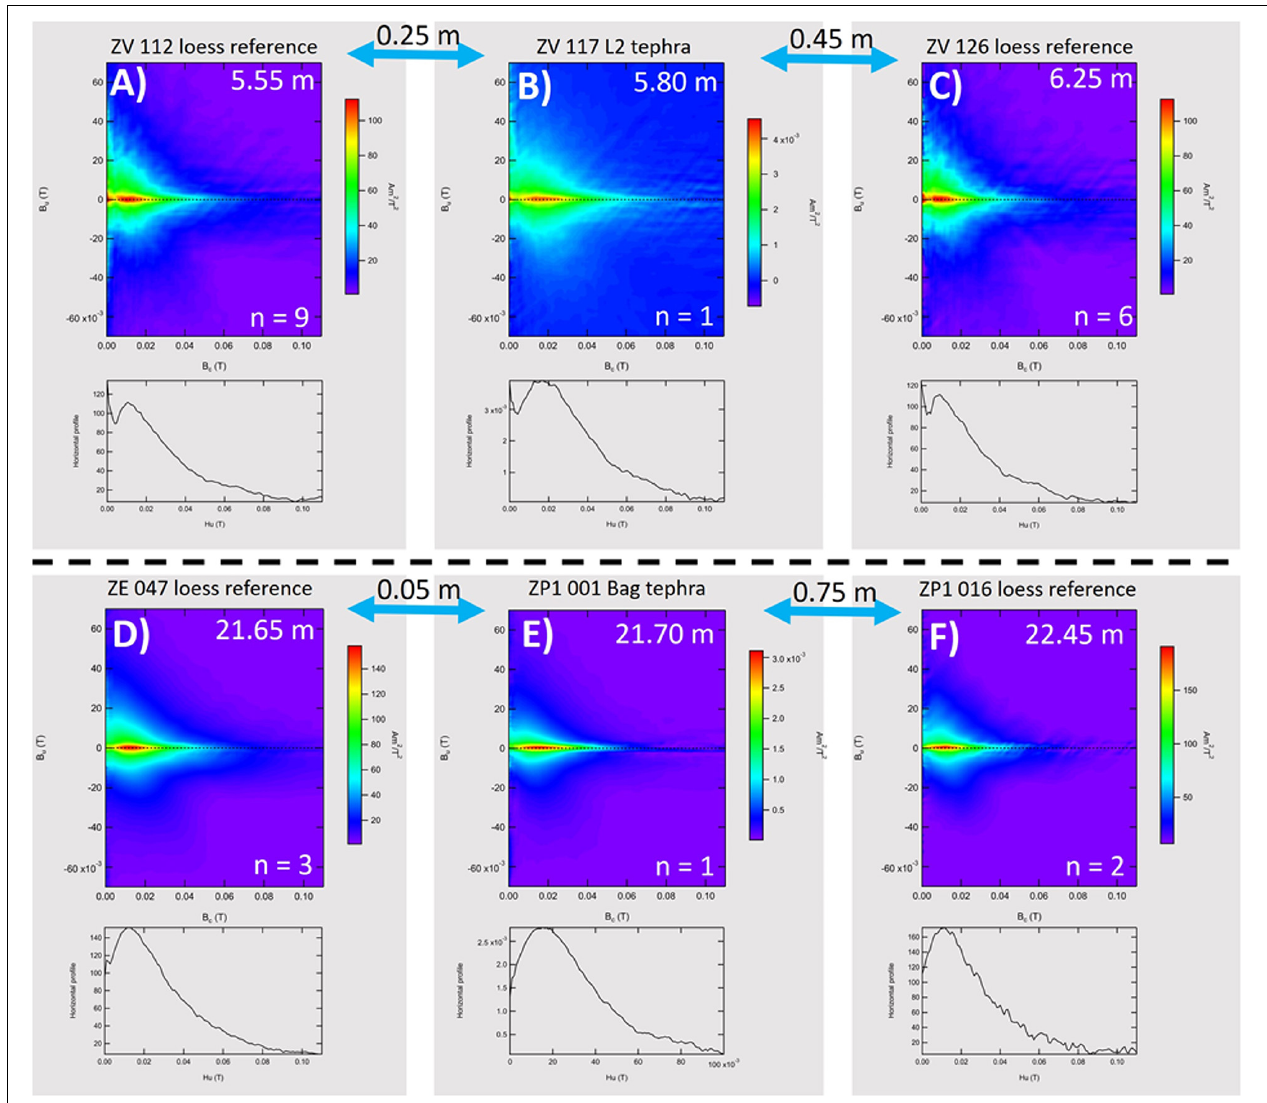
FIGURE 6 | FORC plots and related central ridge profiles of the tephra samples [ZV117, (B) for L2 tephra and ZP1001 for the Bag tephra, (E) ] and neighboring reference loess samples [ (A,C) for the bracketing loess samples of the L2 tephra and (D,F) for bracketing loess samples of the Bag tephra]. Blue arrows between the plots indicate the stratigraphical distance between the